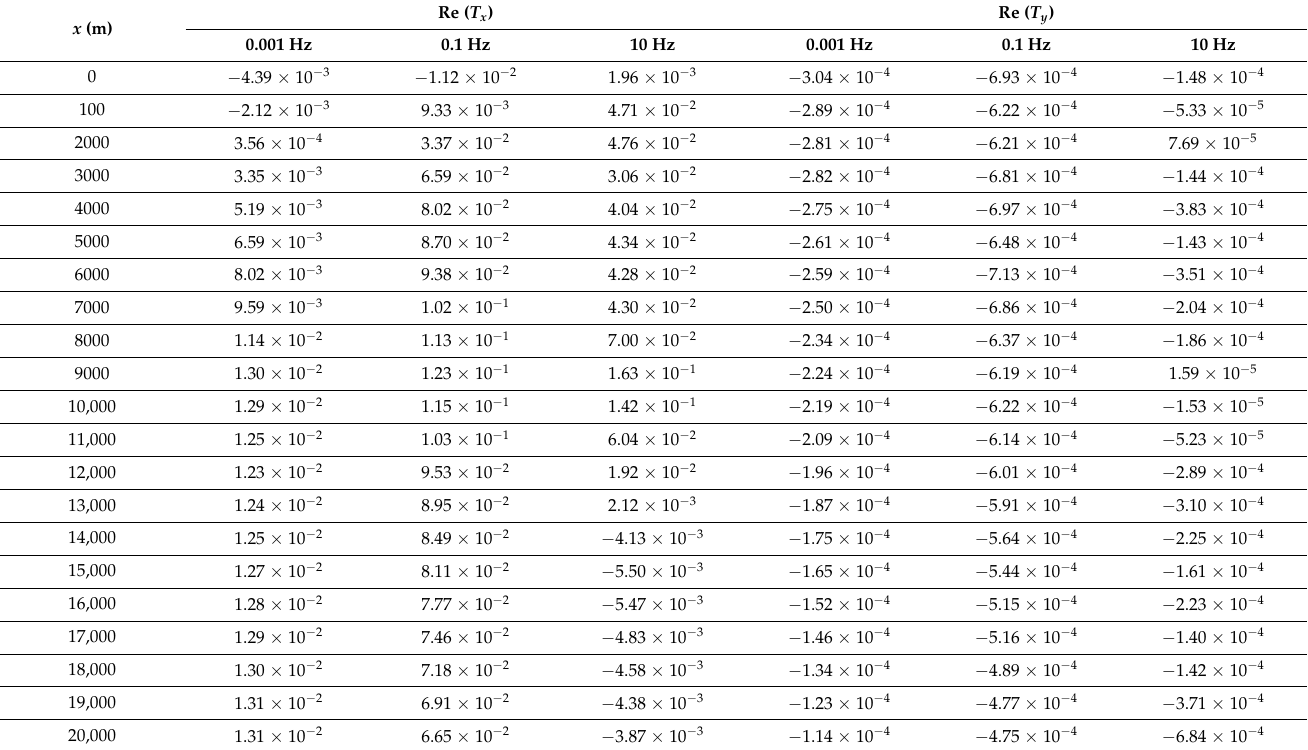
Table 8. The real parts of the tipper transfer function calculated by the FE method for Model 12, as shown in Table 6. The y -coordinate is 0